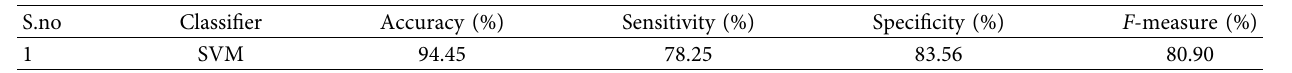
Table 10: Performance of SVM classifier after intersection on Gene Microarray dataset.